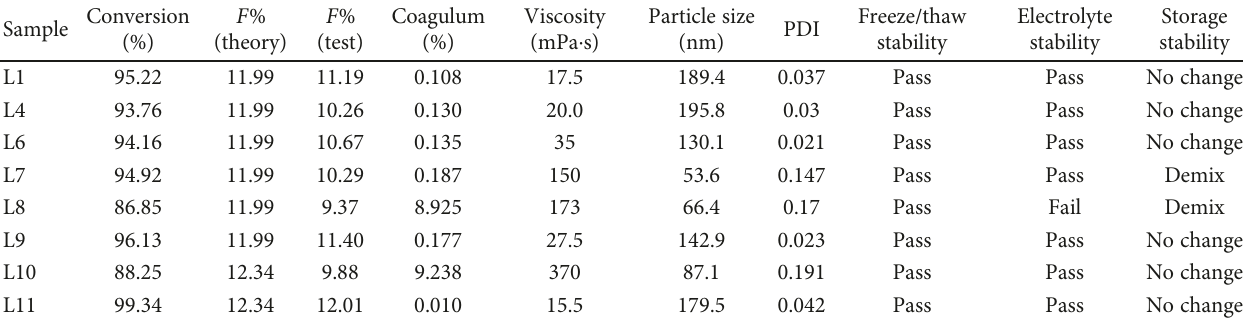
Table 2: In fl uence of the nine stable pre-emulsions on the prepared emulsion properties. Conversion Sample (%)